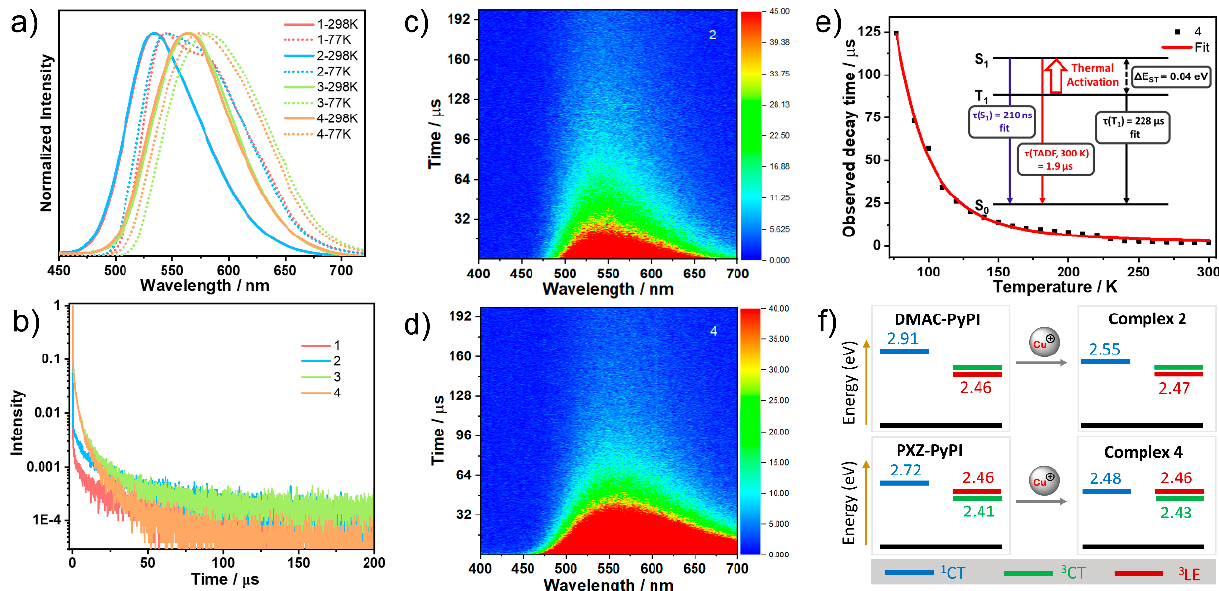
Figure 4. Photophysical properties of the Cu(I) complexes in DPEPO films: ( a ) photoluminescence (PL) spectra at 298 K